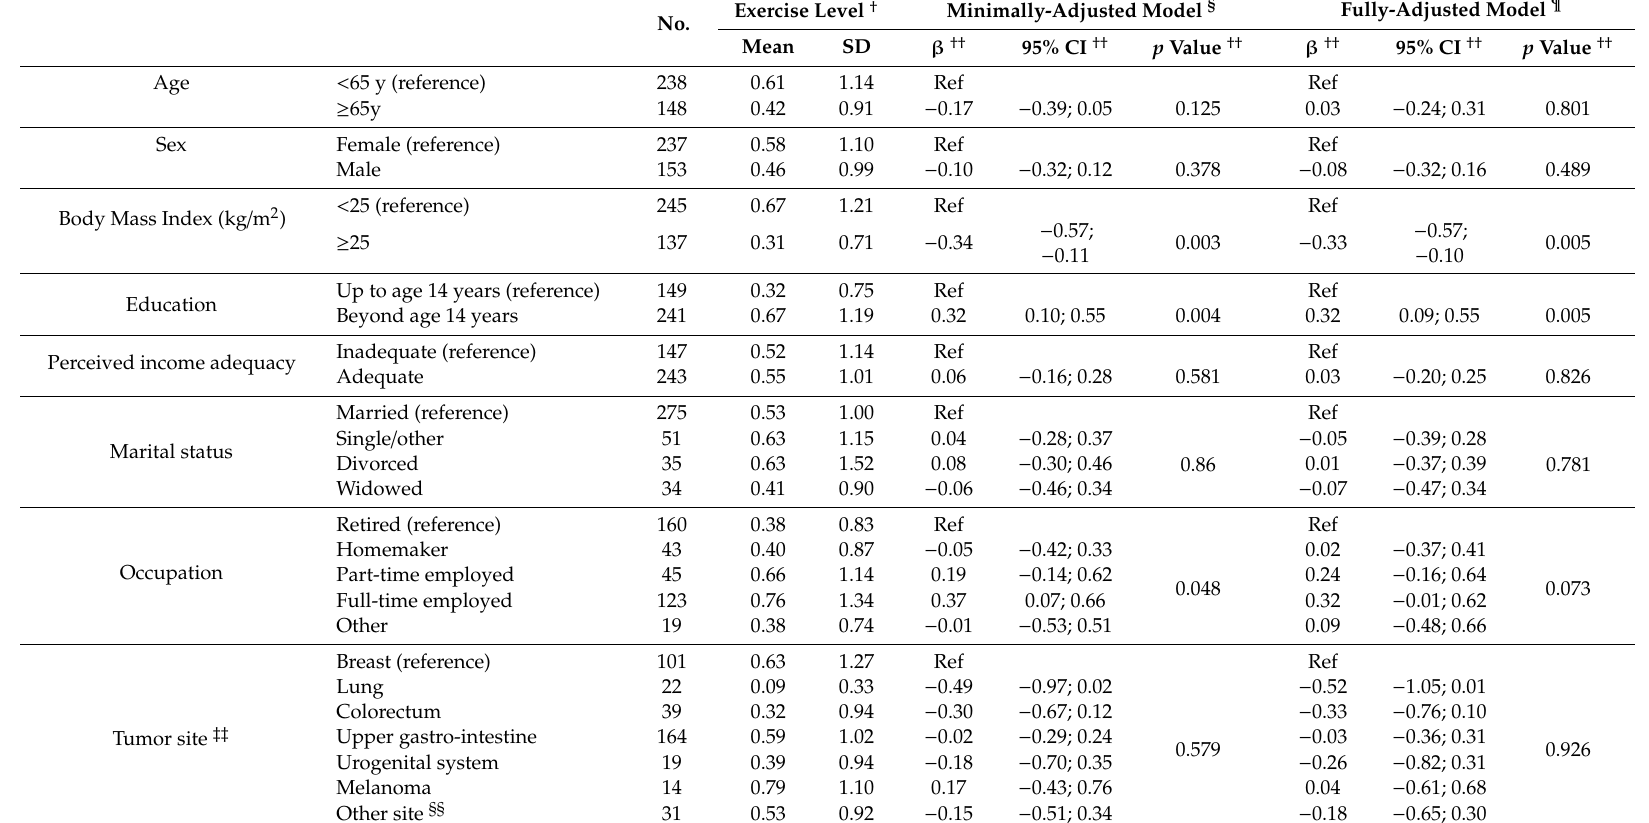
Table 5. Multivariable regression modeling of associations of characteristics of 392 cancer patients † with exercise level ‡